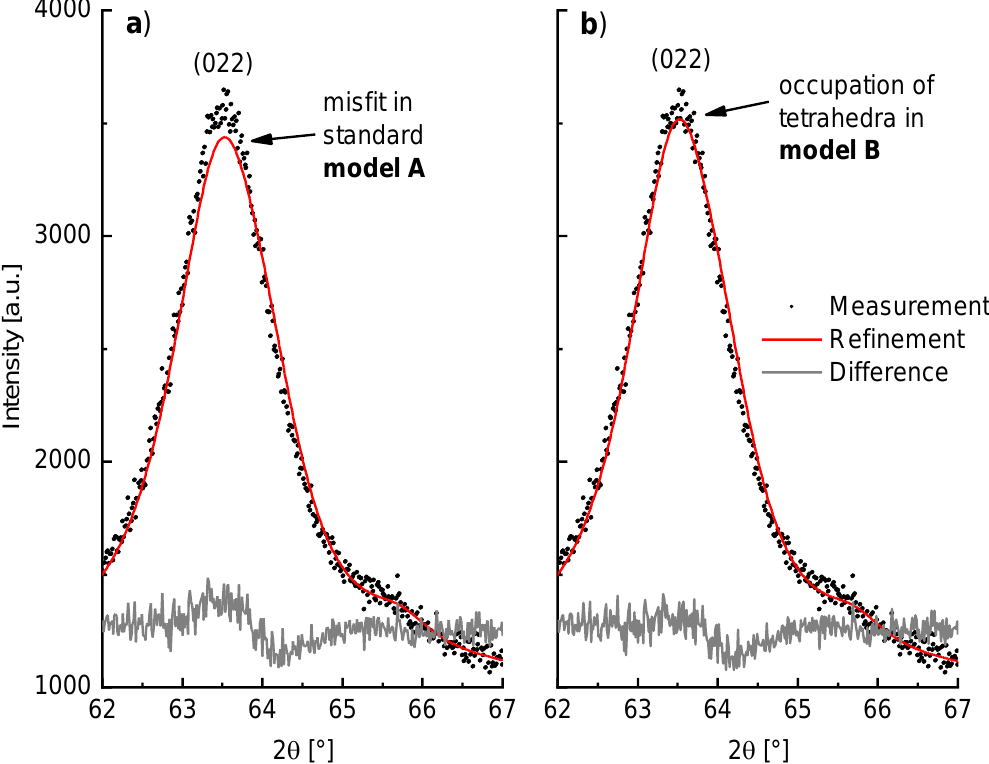
Figure 11. Rietveld refinement of milled β -Li 2 TiO 3 (WC tools, 600 rpm, 6 h) with ( a ) the ideal NaCl structure model and ( b ) a NaCl structure with mixed Li occupation in octahedra and tetrahedra gaps. Refinement parameters: ( a ) R Bragg = 0.60%, GOF = 1.13 and ( b ) R Bragg = 0.28%, GOF = 1.11.